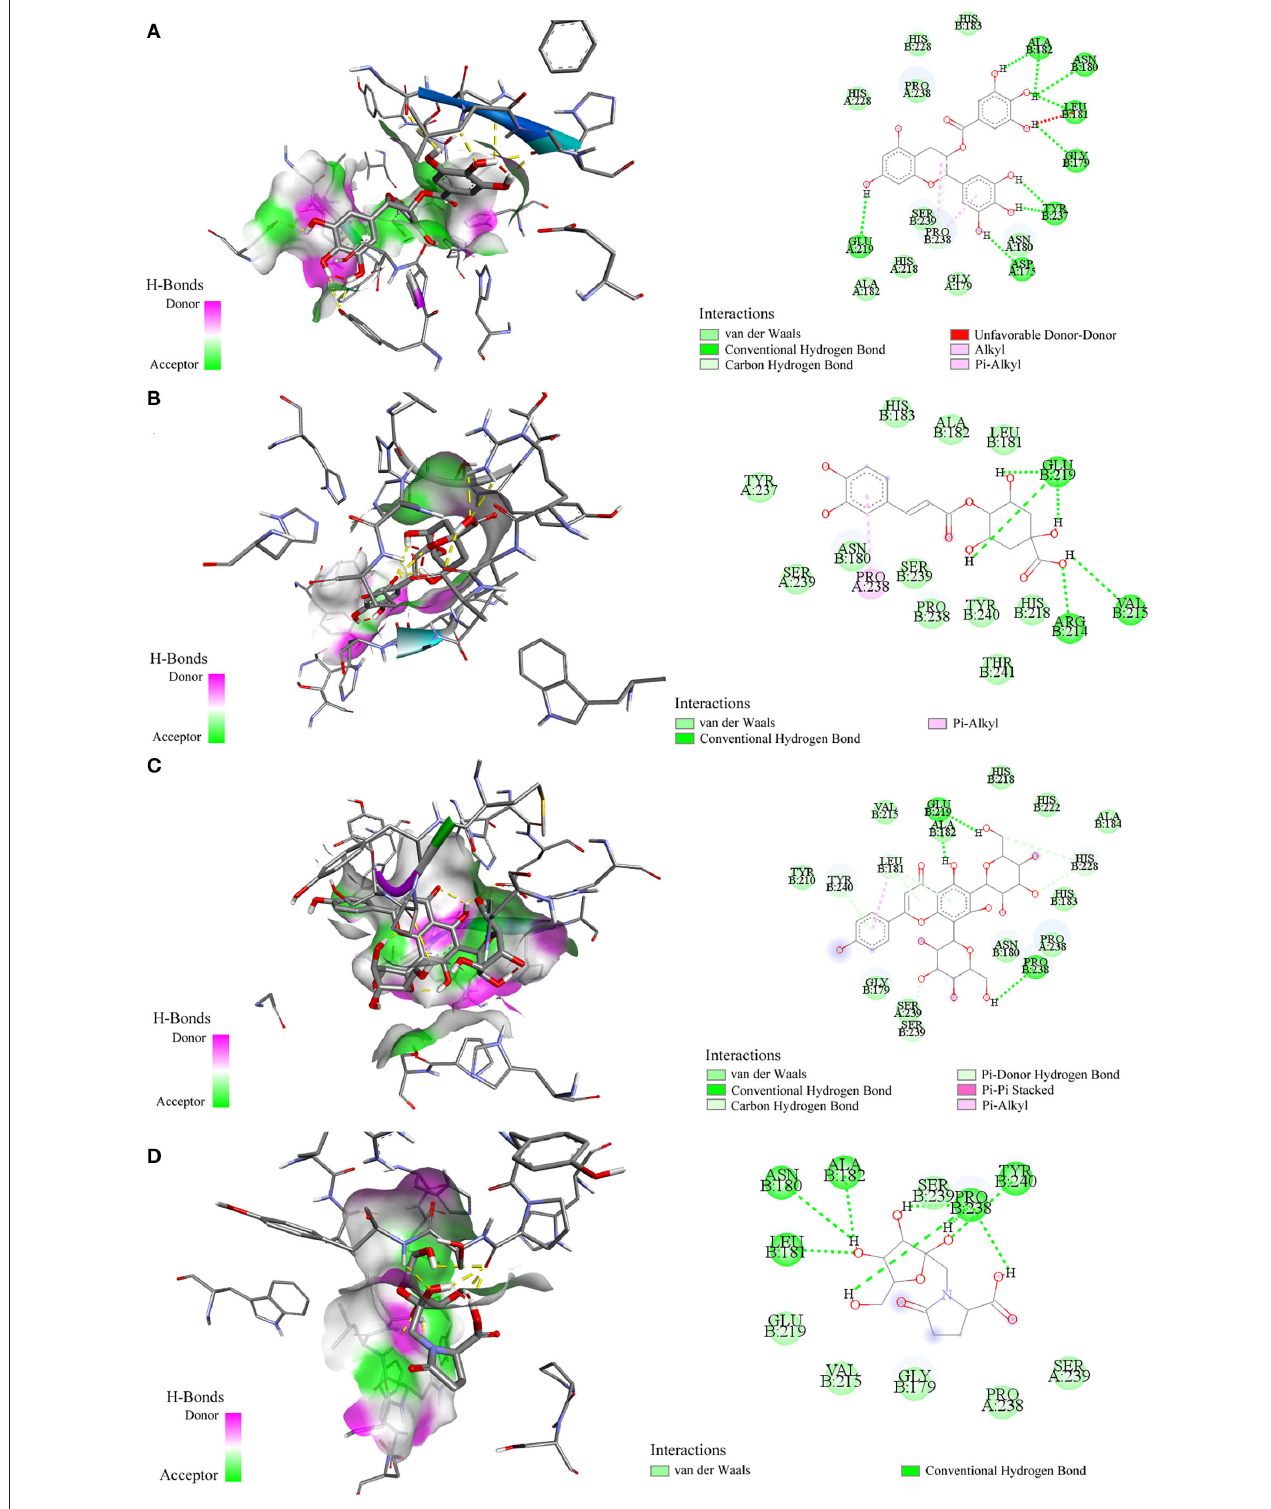
FIGURE 4 | Interactions between collagenase and epigallocatechin gallate (A) 4-caffeoylquinic acid (B) vicenin-2 (C) and N-fructosyl pyroglutamate (D) by molecular docking analysis, respectively.